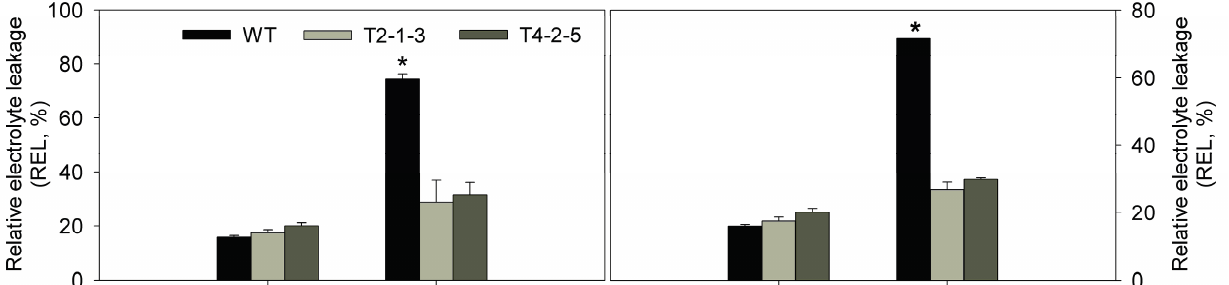
Figure 4. Physiological analysis of WT and CaTIP1-1- overexpressing transgenic lines under normal conditions and osmotic stress. Changes in relative water content (RWC), relative electrolyte leakage (REL) and malondialdehyde (MDA) were measured in the leaves of WT and CaTIP1-1- overexpressing transgenic lines (T2-1-3 and T4-2-5, which are independent transgenic lines) under normal conditions or osmotic stresses (0.15 M NaCl or 0.25 M mannitol for 12 h). The results are the mean ± standard error (SE), replicated thrice. * indicates significant difference when compared with the control at a p value